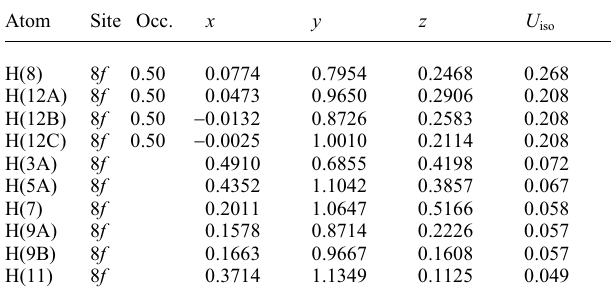
Table 2. Atomic coordinates and displacement parameters (in Å 2 )